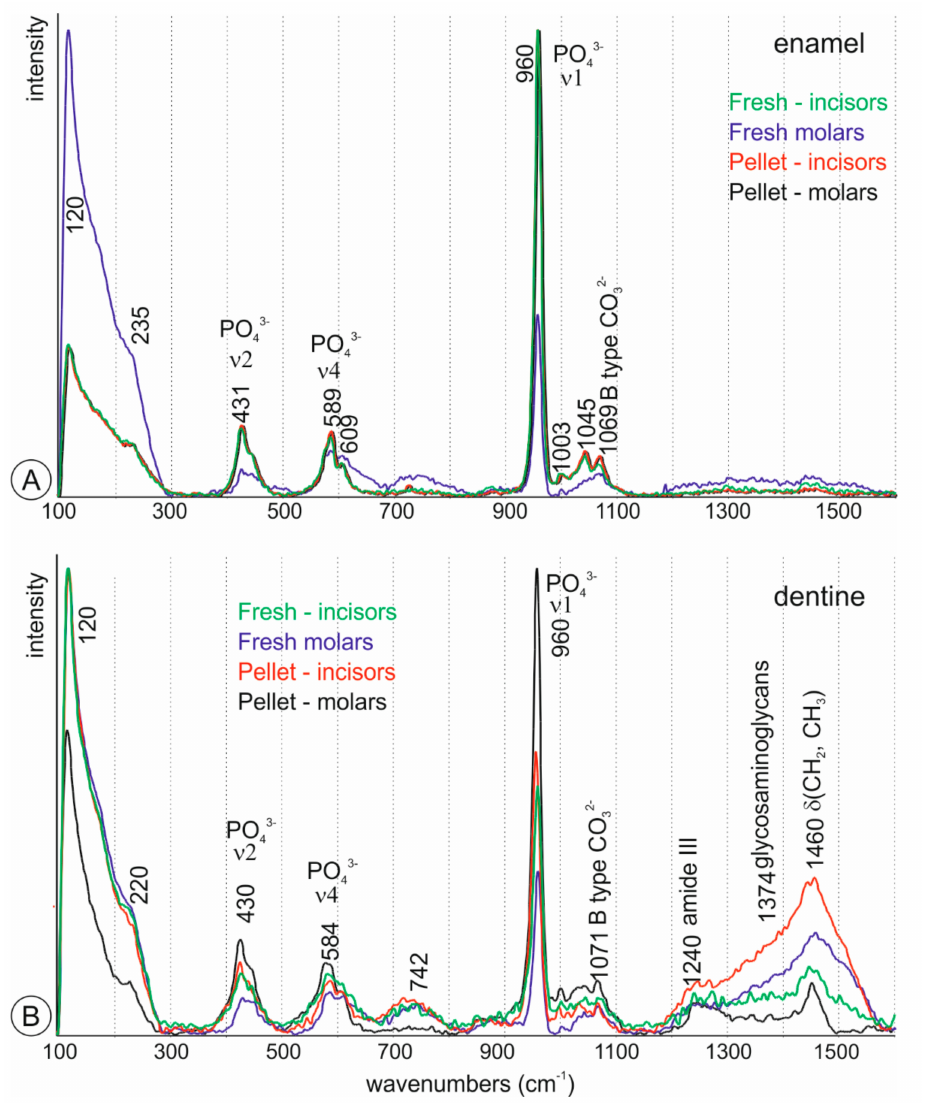
Figure 2. Raman spectra of fresh and digested teeth. ( A )—Average spectra of enamel; ( B )—Average spectra of